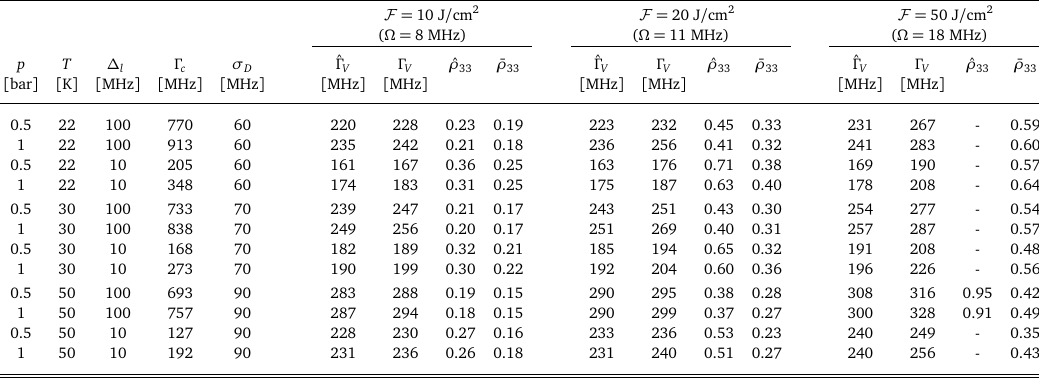
Table 4: ˆ Γ from the analytical expression of equation (26), FWHM line-width Γ ex- V V tracted from fitting the line-profile obtained from numerical integration of the Bloch ( ω ) from the analytical expression of equation (19) equations for various ω , ˆ ρ r 33 ( ω ) from the numerical integration of the Bloch equations. τ = 100 ns and ¯ ρ r 33 and Boltzmann distribution between ortho- and para-H are assumed (for τ = 10 ns 2 > 1, and a statistical distribution see Appendix B). The symbol “-“ indicates that ˆ ρ 33 which is